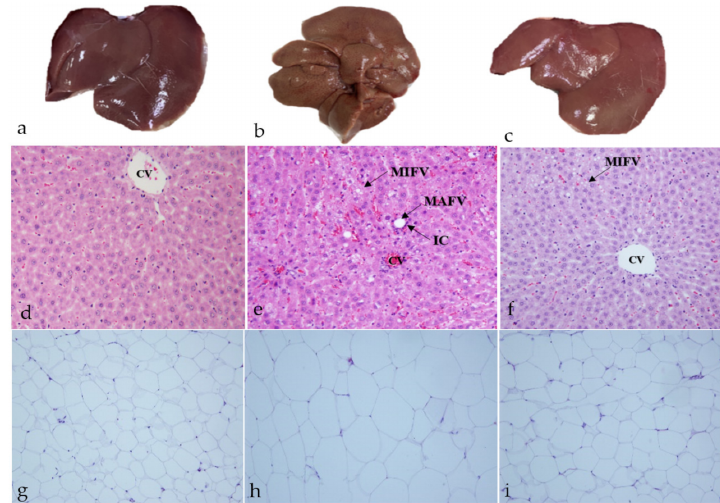
Figure 5. Liver gross anatomy and H&E of the control group ( a , d ), HFD group ( b , e ), and HFD + LYC group ( c , f ). All pictures were taken at 40 × magnification. Histological changes in the WAT stained with H&E in ( g ) the control group, ( h ) the HFD group and ( i ) following treatment with LYC in HFD-induced obesity in rats, magnification was 20 ×